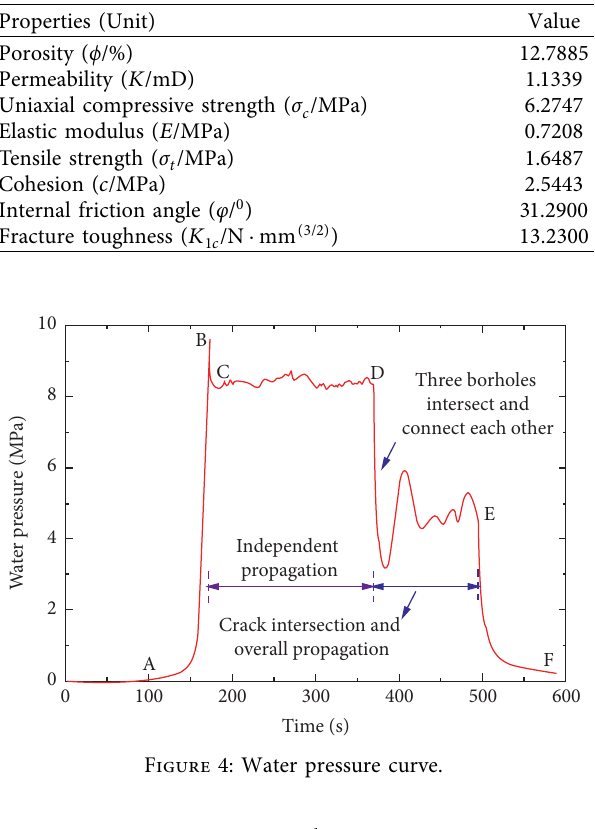
Figure 4: Water pressure